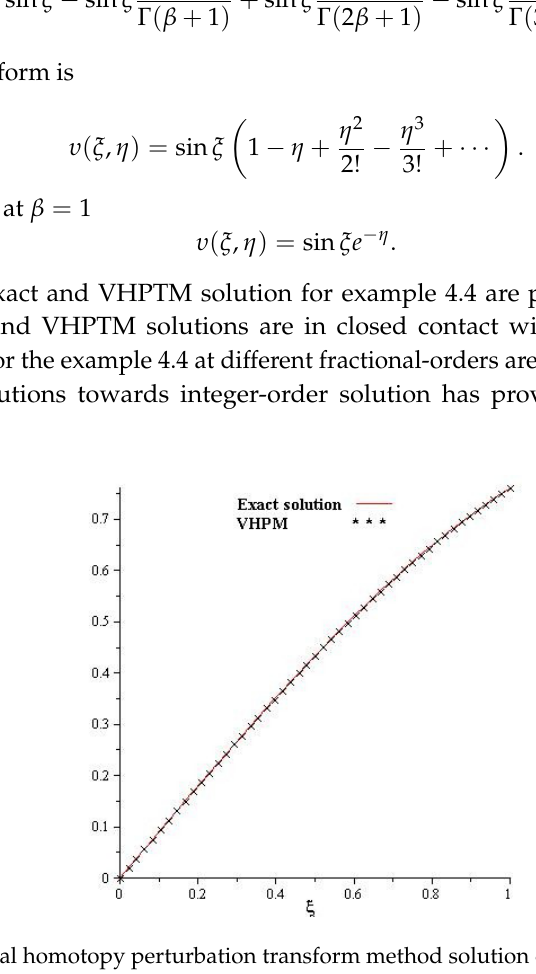
Figure 7. Variational homotopy perturbation transform method solution of example 4.4 for β =